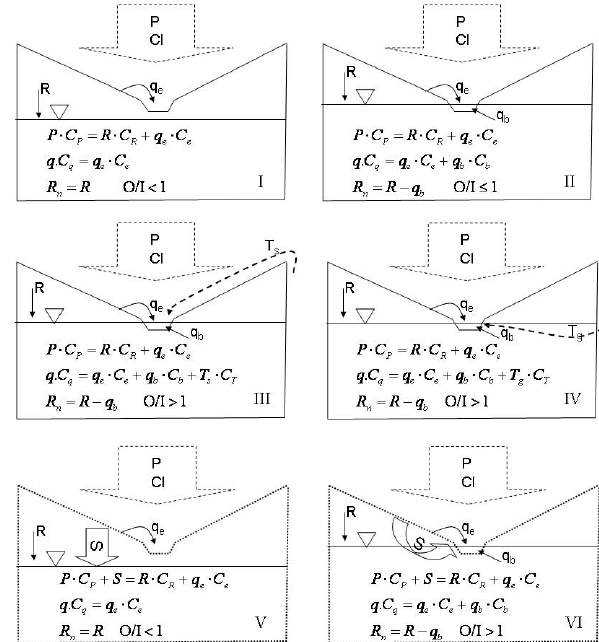
ious conditions: (I) Chloride steady state with a losing stream, (II) Chloride steady state with a gaining stream, (III) Chloride steady state, with cross-catchment surface water transfer, (IV) Chloride steady state, with cross-catchment subsurface water transfer,